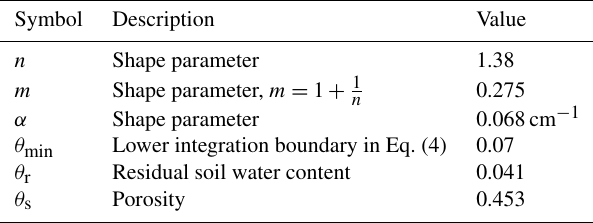
Table B1. Parameters used for calculation of soil hydraulic properties using van Genuchten